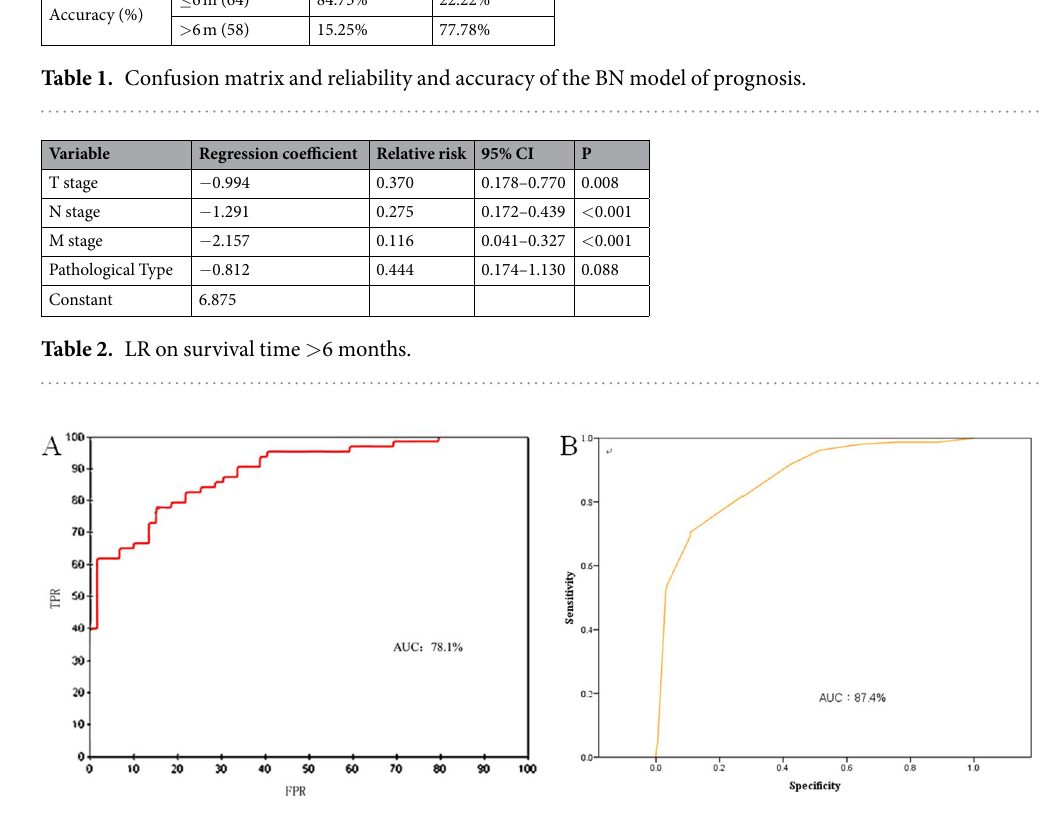
Figure 2. ( A ) ROC curve of survival time > 6 months for BN. ( B ) ROC curve of survival time > 6 months for LR.